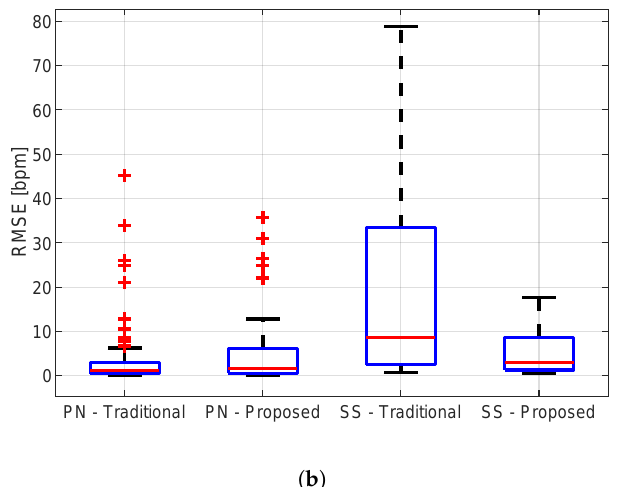
Figure 12. Boxplot of the results obtained on the DS-PN and DS-SS with VA and the proposed methods. ( a ) F1-score ( b ) RMSE.